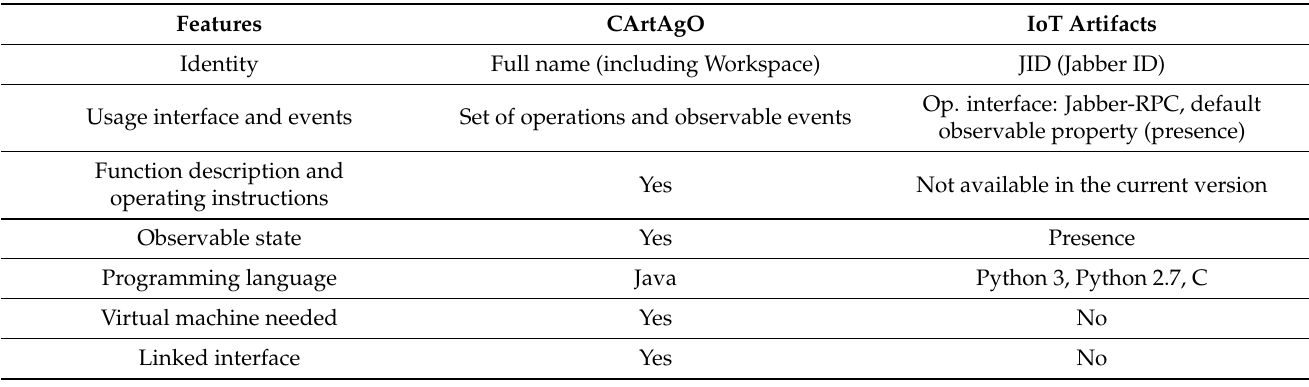
Table 1. Comparison of features between CArtAgO and IoT